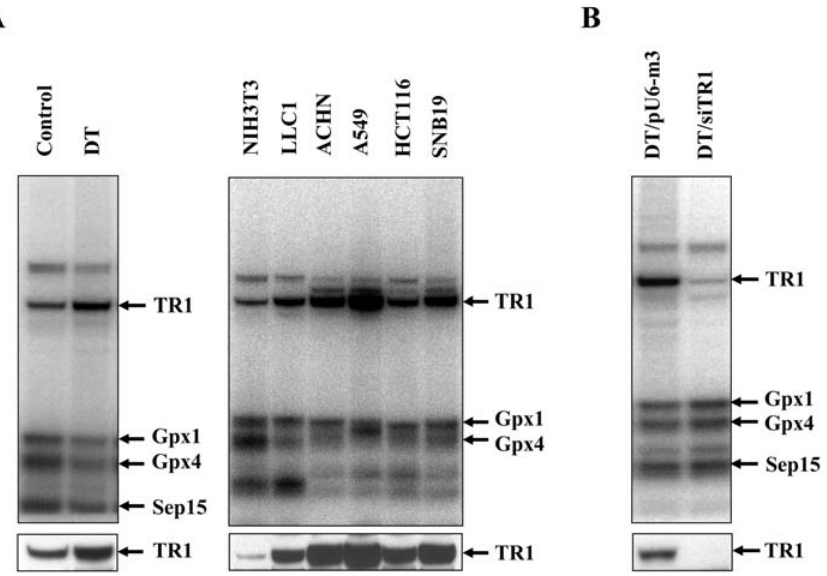
Figure 1. Thioredoxin reductase (TR1) expression in mouse and human malignant cells. Indicated cell lines were metabolically labeled with 75 Se, the resulting protein cell extracts electrophoresed and the gels exposed to a PhosphorImager (see Methods). Selenoproteins identified previously in cell extracts [25,26] are indicated by an arrow and name on the right of each panel. TR1 was also identified by western blotting in protein extracts of each cell line as shown in the lower panels. ( A, left panel ) Control (parental; NIH3T3) and DT cells. ( A, right panel ) NIH3T3 (control, parental cells used in generating DT cells), LLC1 (mouse Lewis lung cell carcinoma), ACHN (human kidney renal cell carcinoma), A549 (human lung non-small cell carcinoma), HCT116 (human colon cell adenocarcinoma) and SNB19 (human cell glioblastoma). NIH3T3 was used as an indicator cell line for comparison of TR1 levels in a normal cell line to the malignant cell lines. ( B ) DT/pU6-m3 and DT/siTR1. DT (obtained by overexpression of mutant k- ras in NIH3T3) cells were stably transfected with the pU6-m3 (control) vector or siTR1 knockdown vector, respectively (see